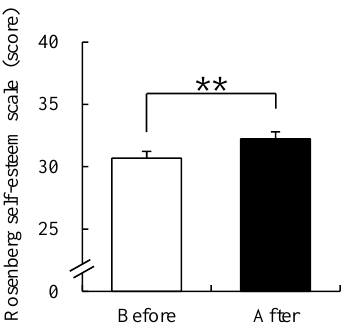
Figure 7. Changes in RES scores before and after the FCA. Data are presented as mean ± standard error ( n = 61). Significance was verified by the Wilcoxon signed-rank test; ** p < 0.01.